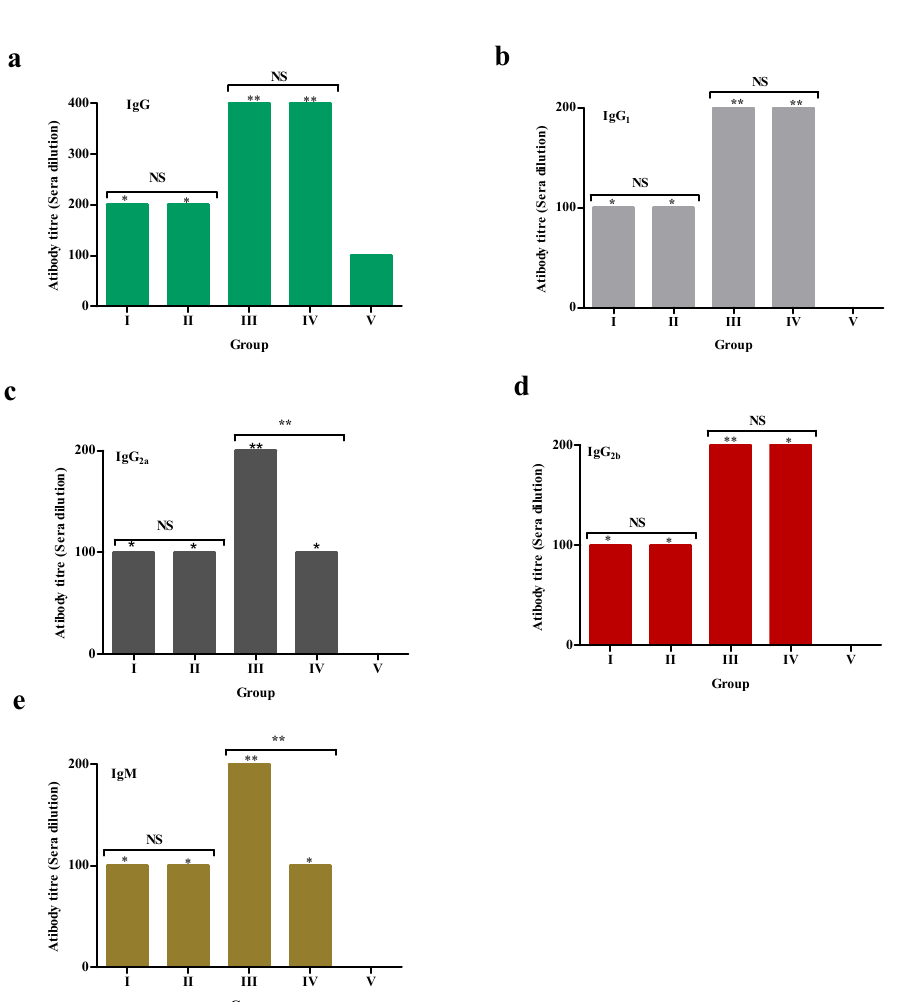
Figure 3. Serum antibody titer of IgG ( a ), IgG 1 ( b ), IgG 2a ( c ), IgG 2b ( d ), and IgM ( e ) recorded in different groups of experimental mice following virulent T. evansi challenge. The serum antibody titer was determined in different treatment groups on day 7 post-challenge. The pooled sera samples were serially double diluted and tested by indirect ELISA. The values for different treatment groups were compared. The ELISA was performed using the group-specific proteins used for immunization, as detection antigen. The asterisks indicate a significant differences between groups (* p < 0.05, ** p < 0.001, NS p > 0.05). The cut-off values were calculated by adding 3SD to mean OD 492 of healthy control mice and were 0.205, 0.185, 0.172, 0.216, and 0.235, respectively, for IgG, IgG 1 , IgG 2a , IgG 2b , and